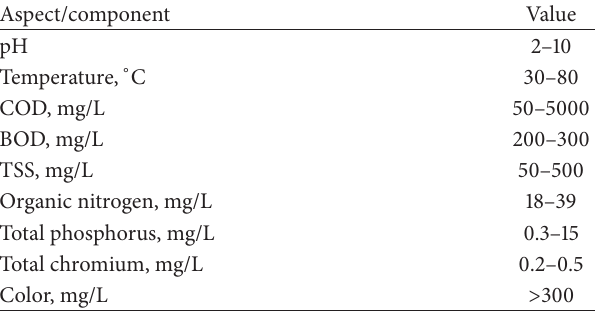
Table 2: Typical characteristics of wastewater from a textile dyeing process. (Table 2 is reproduced from [47]. Copyright 1986, with permission from